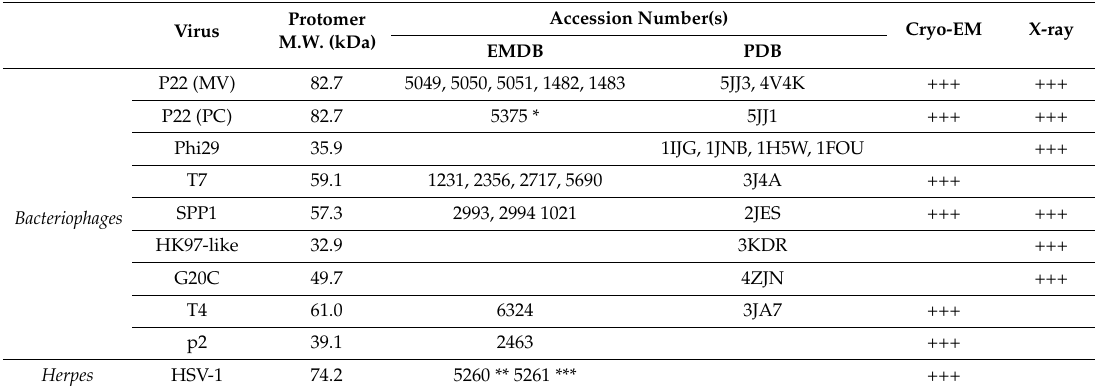
Table 1. Inventory of 3D structures of portal proteins deposited in the Electron Microscopy Data Bank (EMDB) and PDB databases.